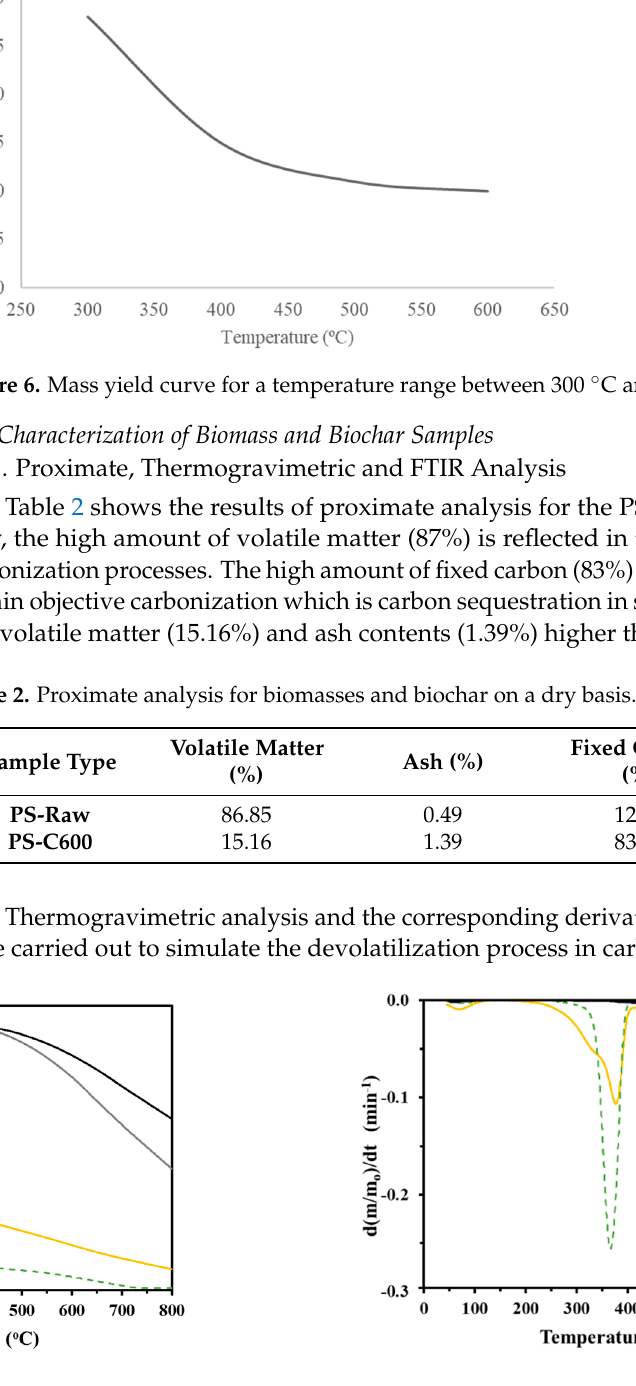
Figure 7. TGA ( left ) and DTG ( right ) of PS-Raw, PS-C600 and PS-AC.